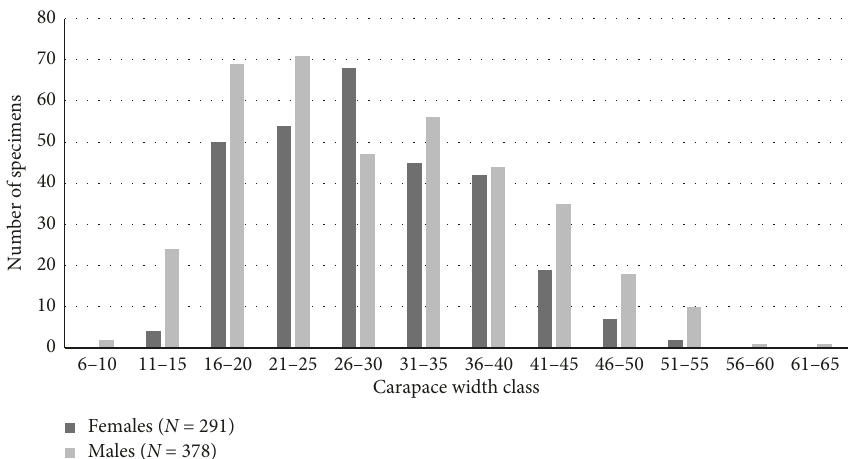
Figure 5: Size frequency distribution of the Potamon algeriense by sex and 5 mm carapace width interval. Table 1: Sex ratio by size class of Potamon algeriense from Oued Zegzel, Morocco, over one year period ( P < 0 . 05).